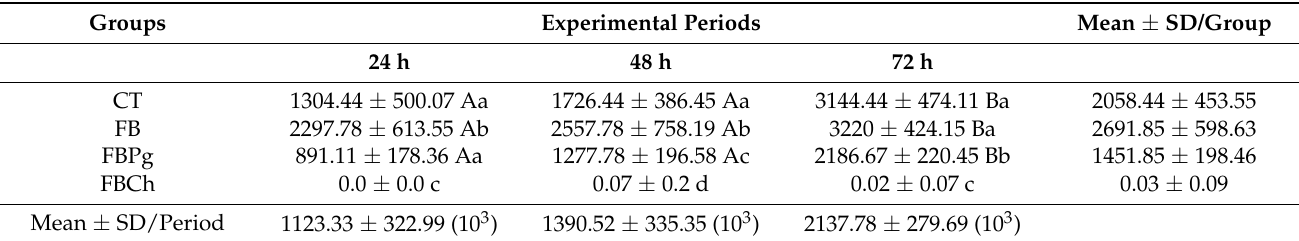
Table 1. Mean values of colony forming unit (CFU)/mL (10 3 ) ± standard deviations (SD) in heat polymerized resin. Groups Experimental